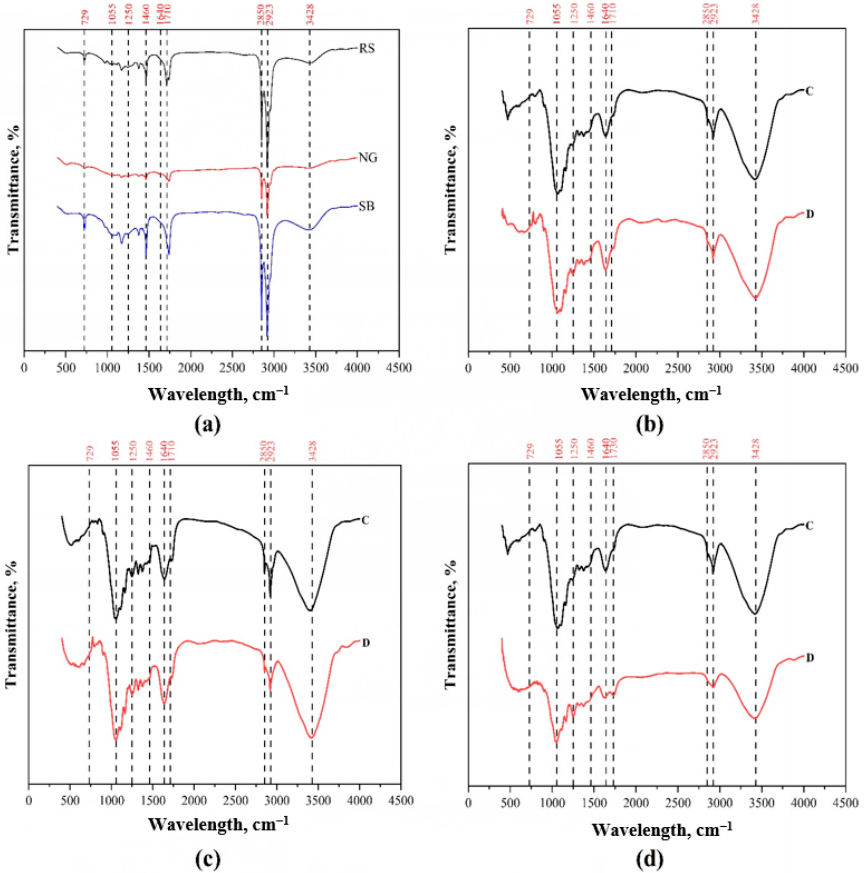
Figure 4. FTIR spectra for wax and different lignocellulosic biomass types. ( a ) IR spectra of wax extracted from RS, NG, and SB; ( b ) rice straw (RS); ( c ) Napier grass (NG); ( d ) sugarcane bagasse (SB).